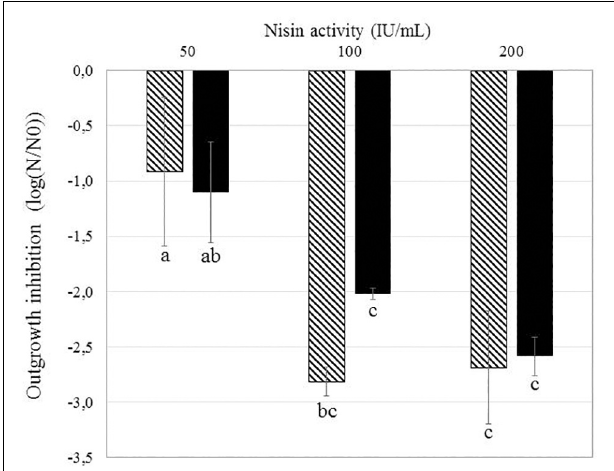
FIGURE 3 | Effect of different nisin concentrations on the reduction of Bacillus subtilis PS533 and B. subtilis PS4150 ( (cid:49) cotE ; (cid:49) gerE ) spore outgrowth. Striped bars: inhibition of B. subtilis PS533 spore outgrowth. Black bars: inhibition of B. subtilis PS4150 ( (cid:49) cotE ; (cid:49) gerE ) spore outgrowth. Error bars represent SD calculated from independent triplicates. The letters represent a significant difference ( p < 0.05) obtained with Tukey’s honest significant difference (HSD) test.